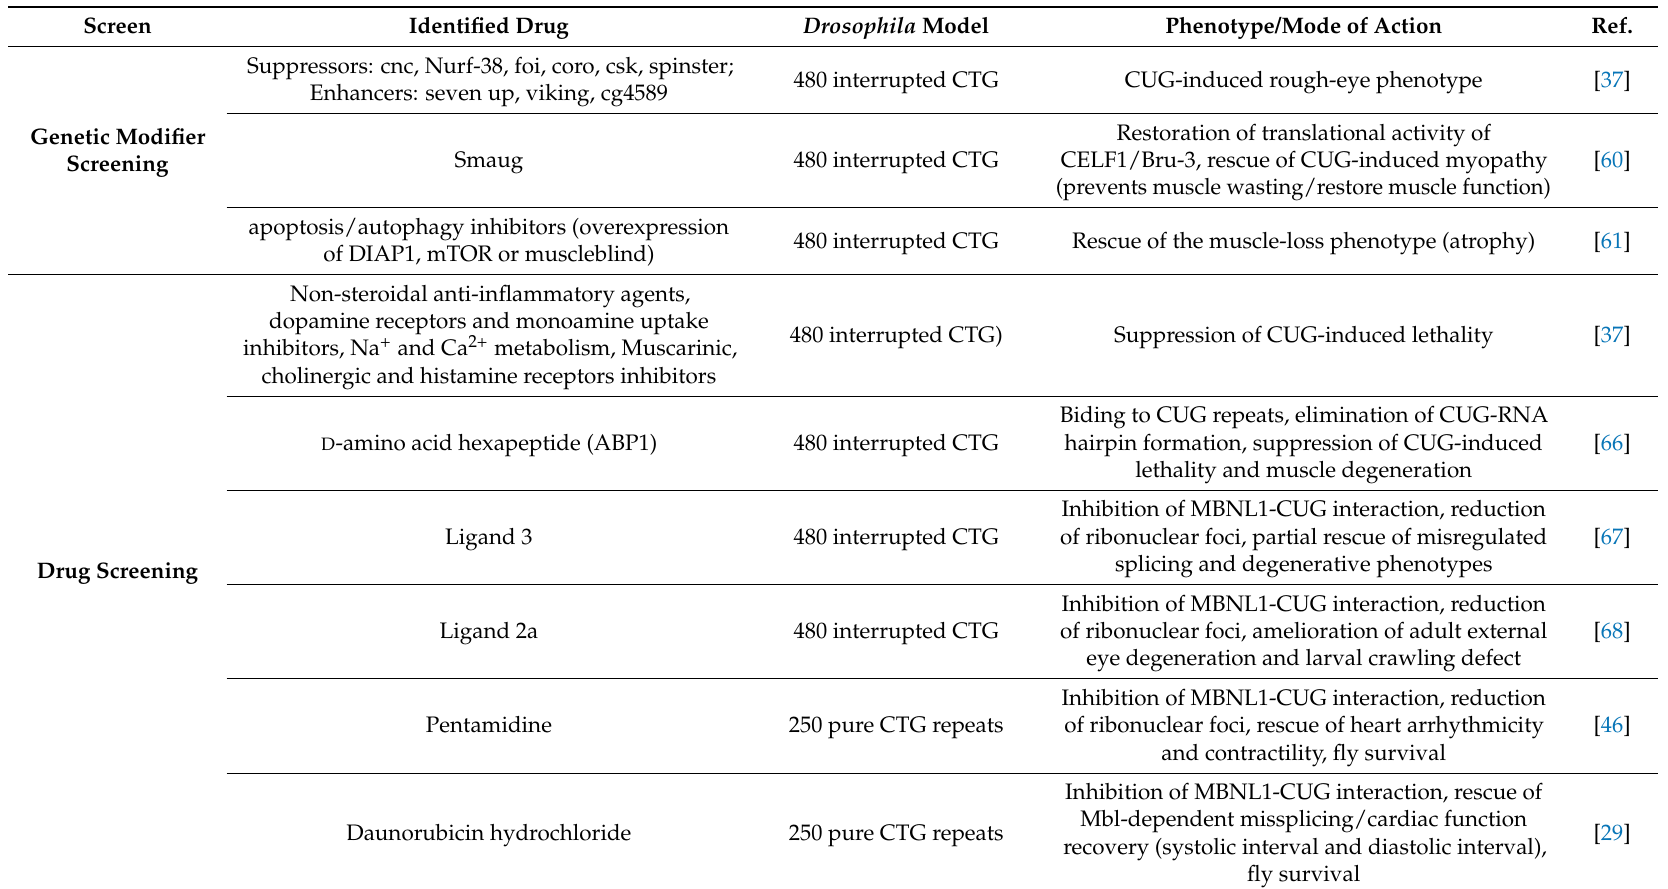
Table 1. Gene and drug screens in fly DM1